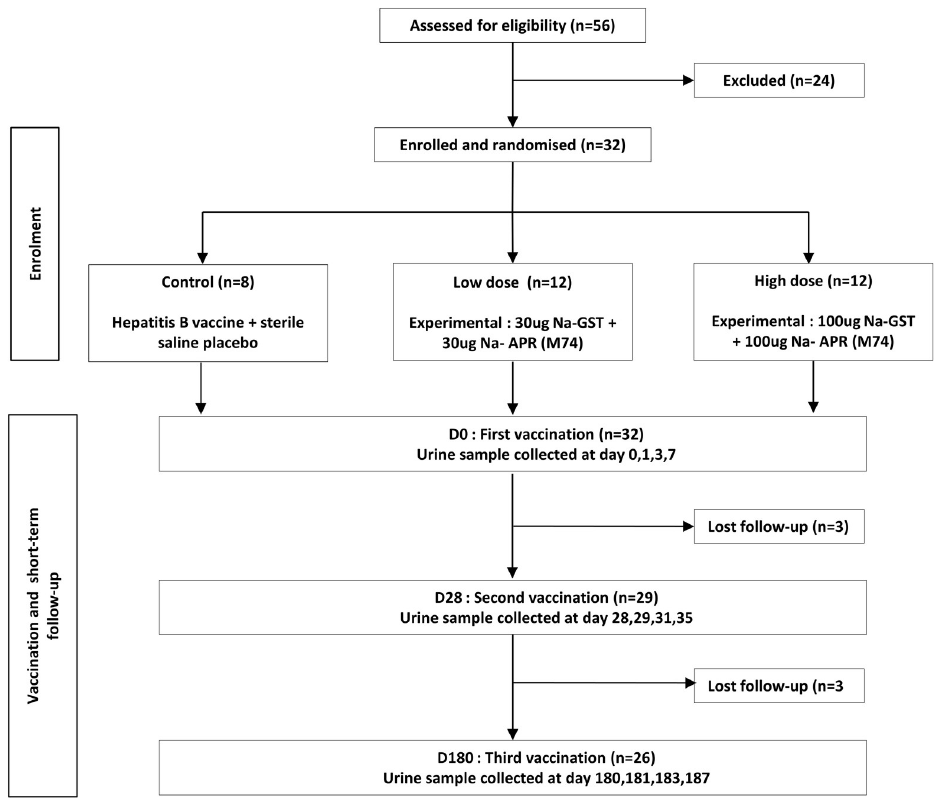
Fig 1. Flow chart of HOOKVAC trial. Participants were vaccinated three times at 0,1,6 months with Hepatitis B or Na-GST-1 plus Na-APR-1 (M74). Urine samples were collected before and after each vaccination at Days 0, 1, 3, 7 after each vaccination